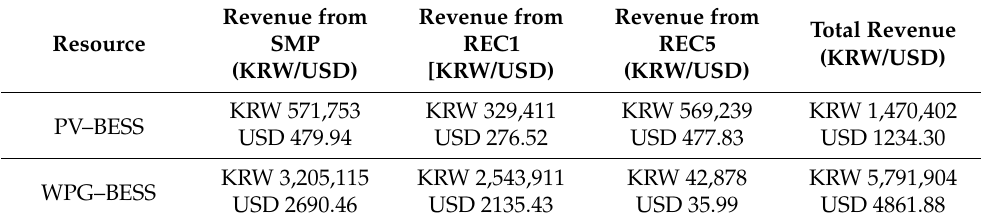
Table 12. Intraday revenue generated with profit maximization with reliability